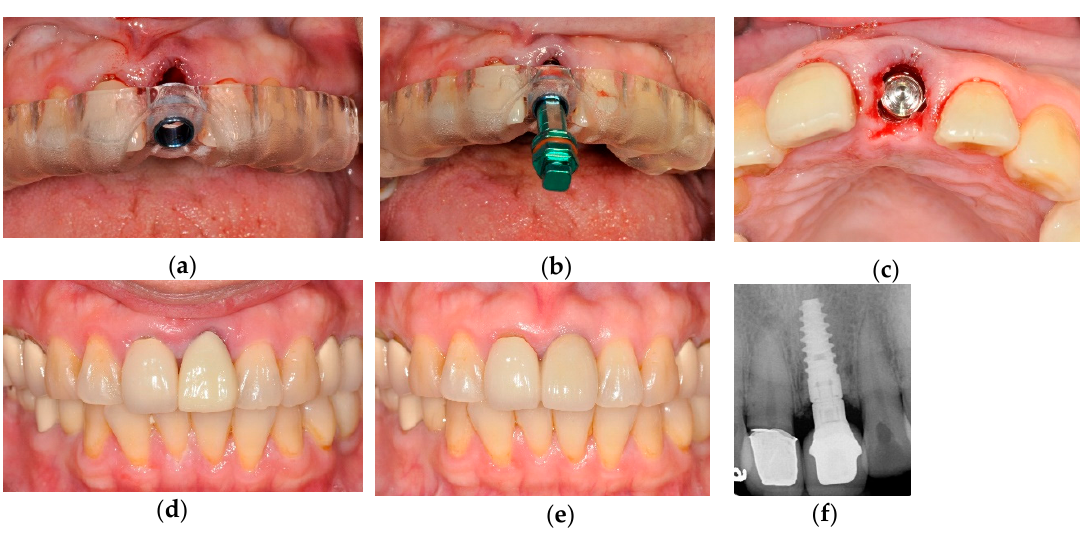
Figure 4. Clinical procedures of the patient in Figure 1. ( a ) An SLA surgical guide was verified for correct seating. ( b ) Fully guided implant placement with the fixture mount. ( c ) An intraoral view of placed implant. ( d ) Provisional restoration the next day after surgery. ( e ) Finished restoration after 6 months of healing. ( f ) Radiograph of the finished restoration after 2